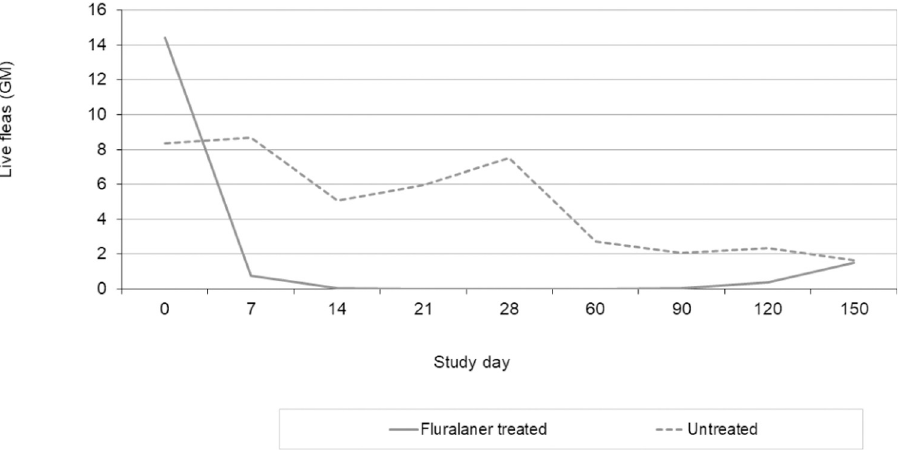
Fig 2. Geometric means of log-transformed live flea counts per study group over time.